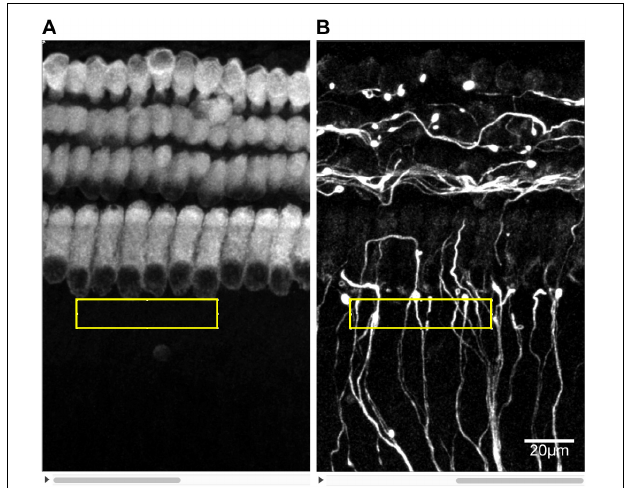
FIGURE 2 | Measuring the density of SGN peripheral fibers. The z-stacks of PSD95 and NF200 8-bit grayscale images of the same area were prepared in ImageJ. (A) A certain rectangular area of 40 × 200 pixels was selected just against the base of IHCs in PSD95 images. (B) The mean grayscale of the same selected area in NF200 images minus that of a background area of the same size was determined as the density of SGN peripheral fibers.